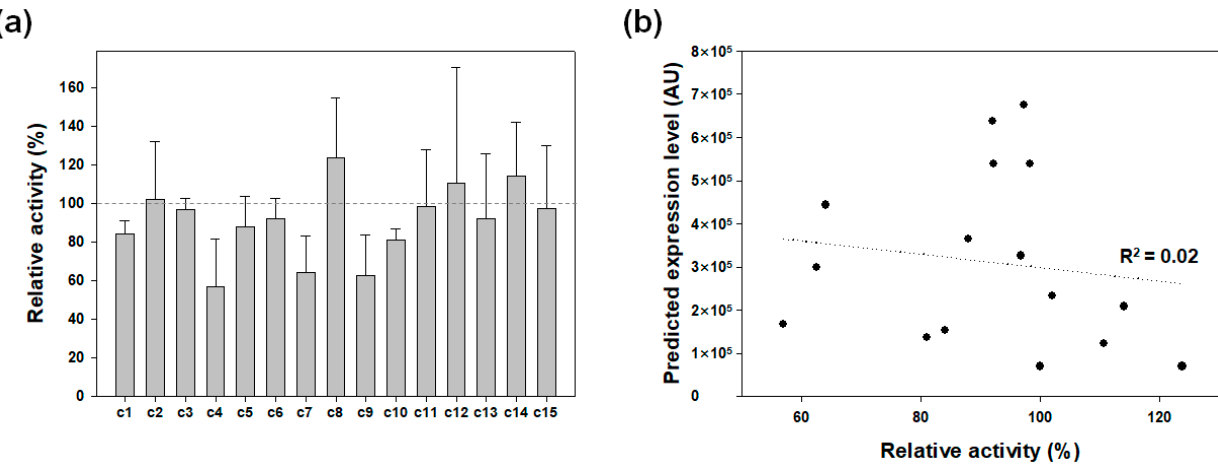
Figure 5. Effect of the codon combination of the ng3 sequence. ( a ) Relative activities of whole-cell lysates of ng3-NEXT- taCA-expressing cells with different codon combinations for the ng3 sequence. The activity of the lysate with the original codons (c0) for ng3 corresponds to the 100% relative activity, which is indicated with the dashed line. Error bars represent standard deviations from two or three independent experiments. ( b ) Relation between activities of cell lysates and predicted expression levels. The dashed line indicates linear regression. AU, arbitrary unit.